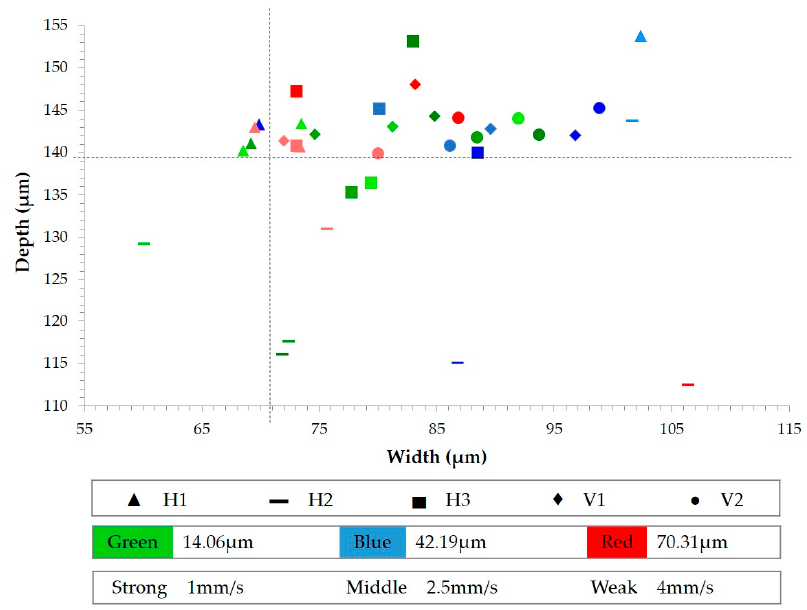
Figure 10. Microchannel dimensions.